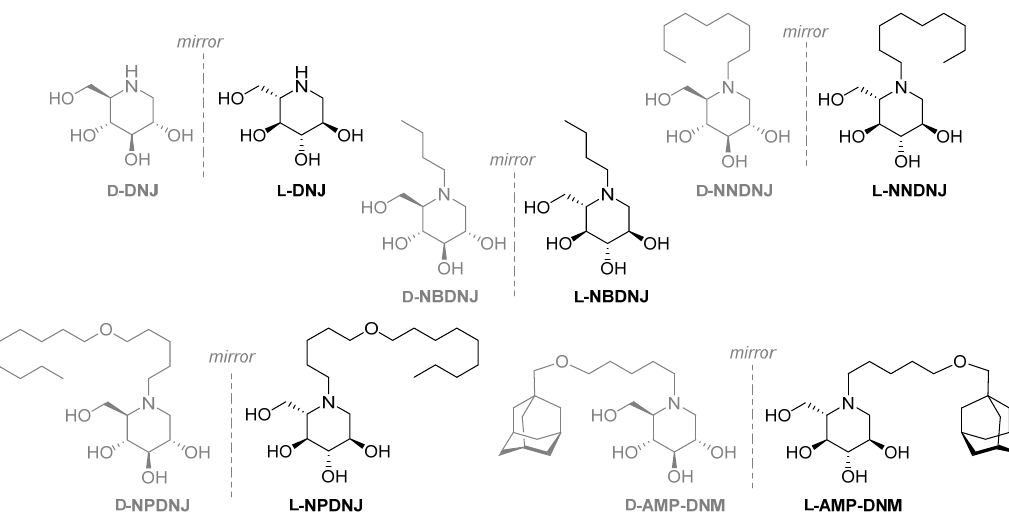
Figure 2. d - and l -deoxyiminosugars studied in this work. DNJ, deoxynojirimycin; NBDNJ, N -butyl DNJ; Figure 2. D ‐ and L ‐ deoxyiminosugars studied in this work. DNJ, deoxynojirimycin; NBDNJ, N ‐ butyl NNDNJ, N -nonyl DNJ; NPDNJ, N -nonyloxypentyl DNJ; AMP-DNM, N -[5-(adamantan-1-ylmethoxy) DNJ; NNDNJ, N ‐ nonyl DNJ; NPDNJ, N ‐ nonyloxypentyl DNJ; AMP ‐ DNM, N ‐ [5 ‐ (adamantan ‐ 1 ‐ pentyl] -1-DNJ.